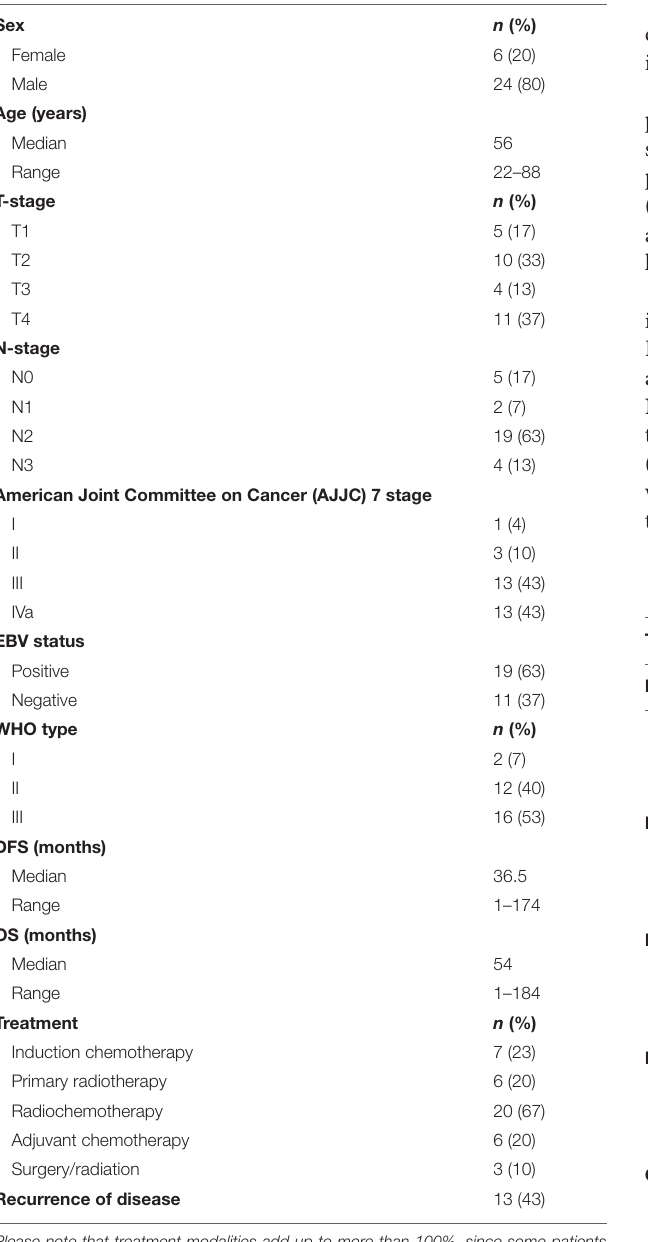
TABLE 1 | Patient characteristics ( n = 30) (100%).